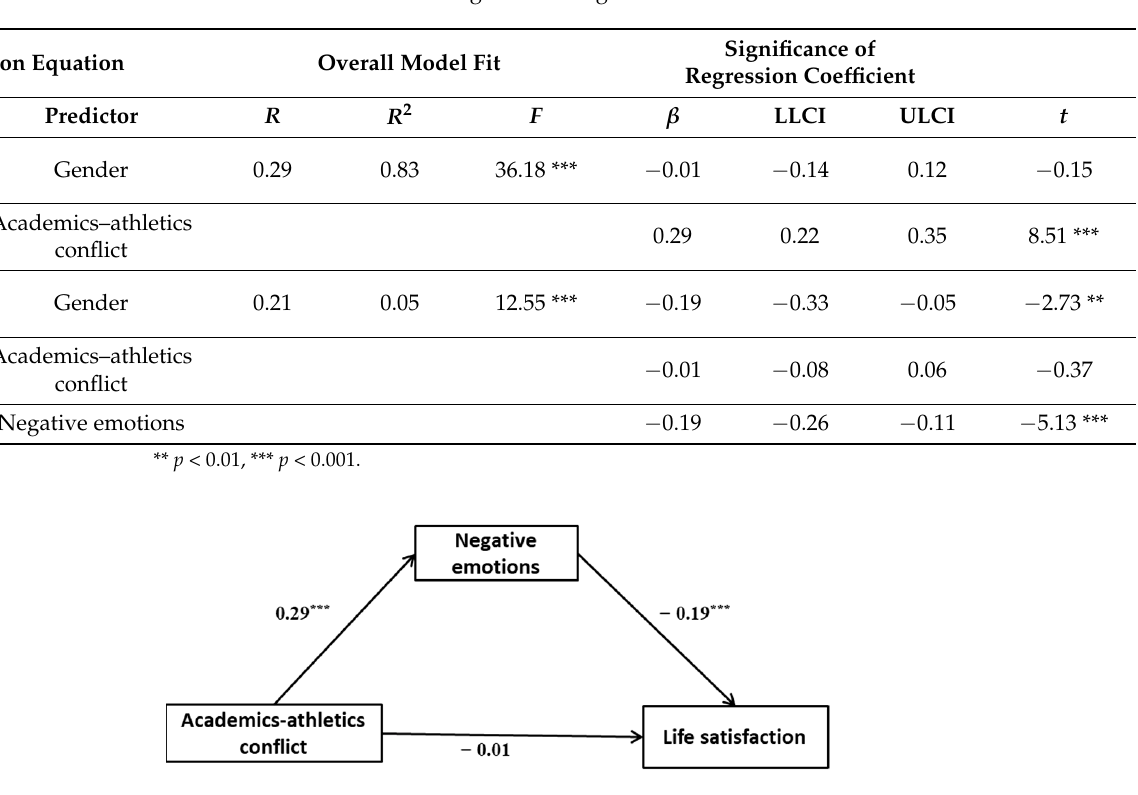
Figure 2. Path coefficients of academics–athletics conflict, negative emotions, and life satisfaction. *** p < 0.001